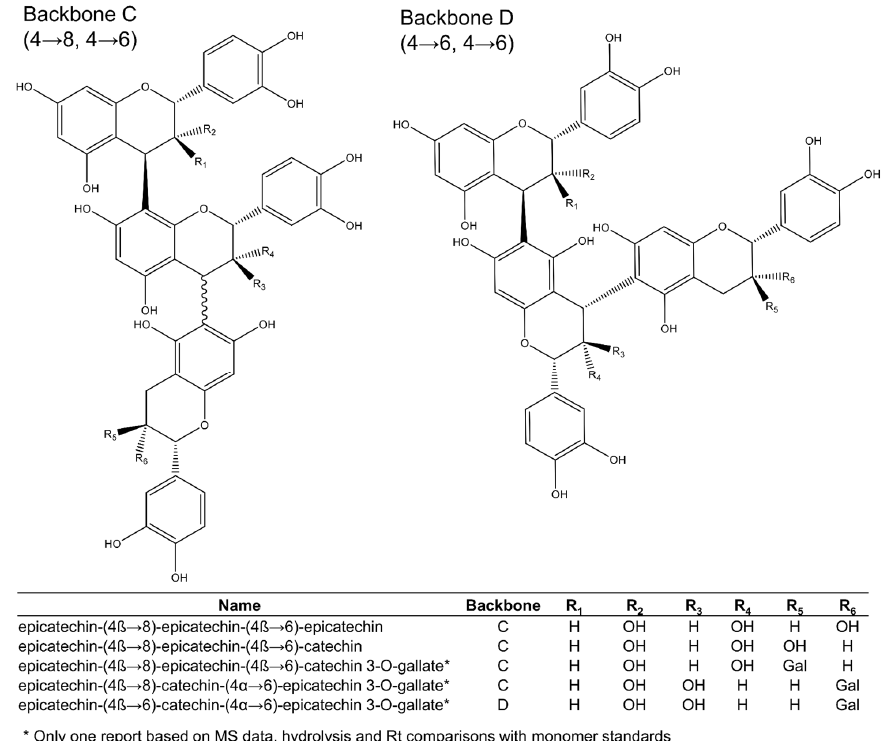
Figure 4. Procyanidin trimers (backbones C and D) reported in grape seeds.